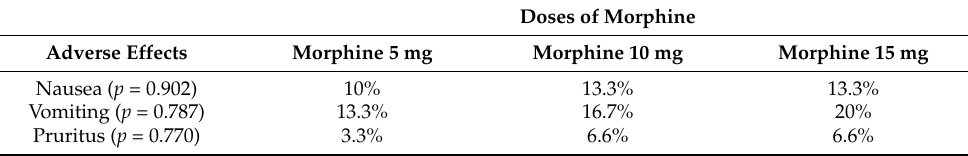
Table 3. Adverse effects among the 90 patients, depending on the morphine dose used